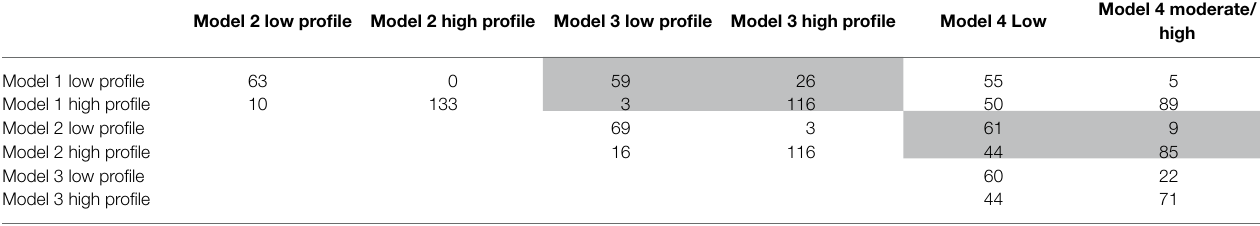
TABLE 6 | Cross-tabulation of classification of children into profiles across